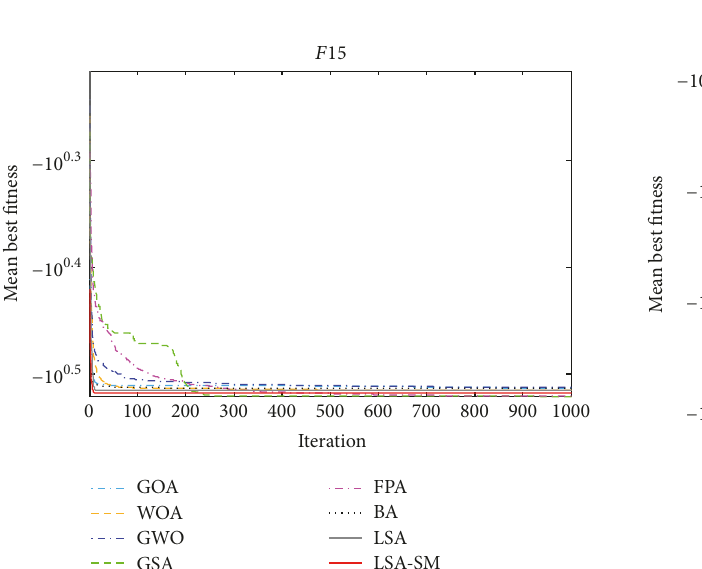
Figure 20: 𝐷 = 4 , convergence curves for 𝑓 16 .